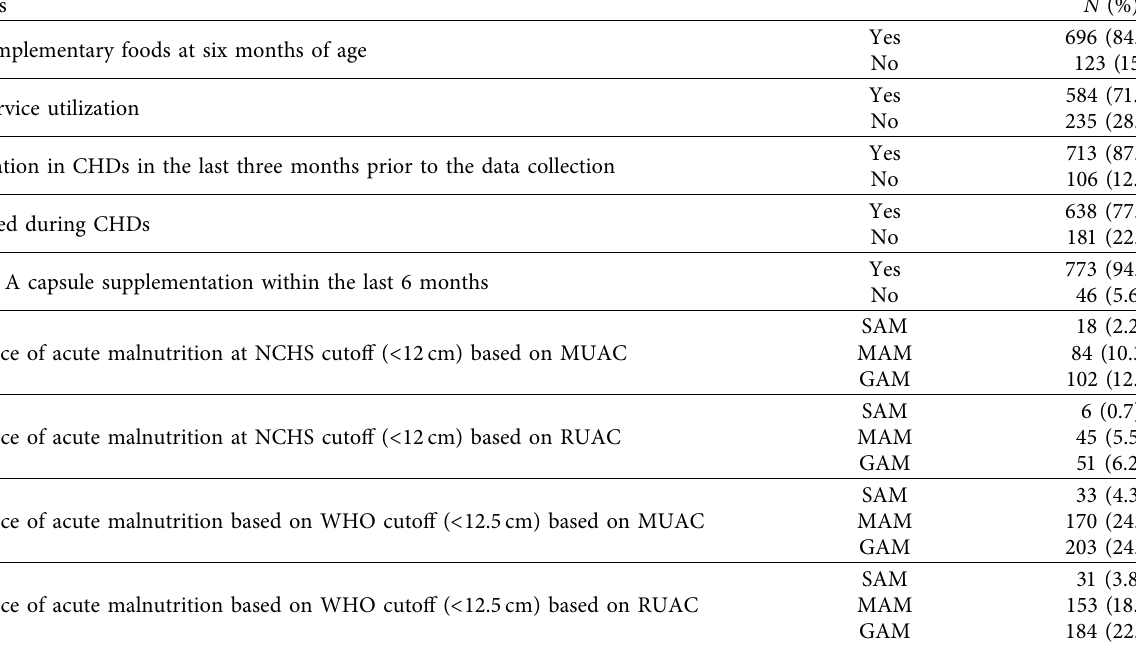
Table 2: Child feeding practices and nutritional status of 6–59-month-old children from Lanfro District, Silte Zone, Southern Ethiopia, 2016 ( n � 819).